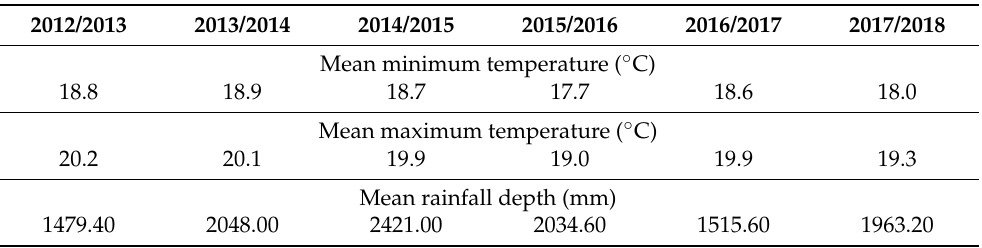
Table 1. Annual mean minimum and maximum temperature and rainfall depths (mean of 2012/2013 to 2017/2018) in Ibirub á , RS, Brazil.